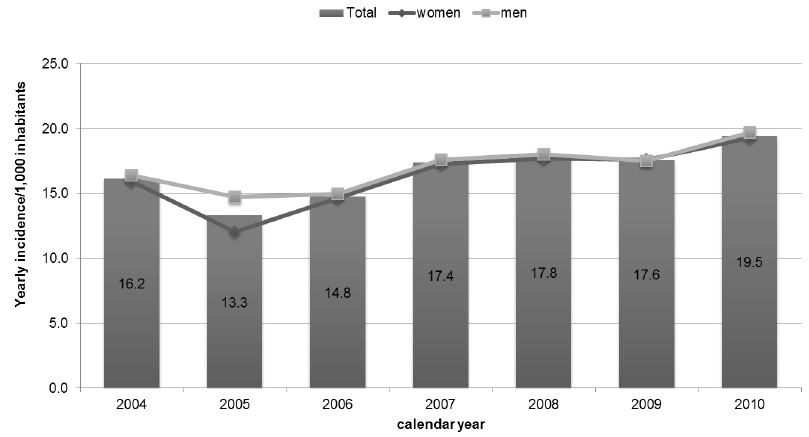
Figure 2. Yearly incidence of statin use/1,000 inhabitants stratified by calendar year and gender.